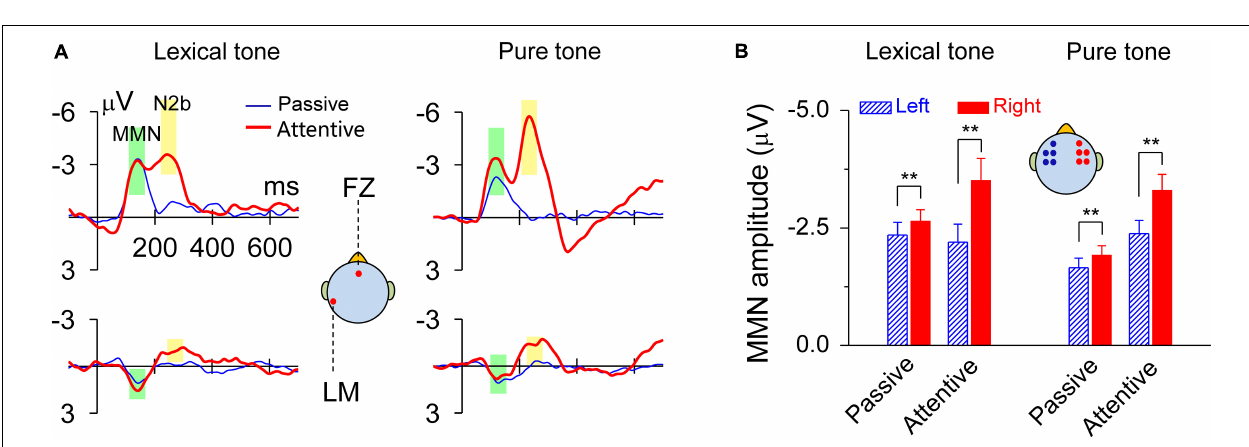
FIGURE 2 | MMN responses to lexical tone contrasts or to pure tone contrasts were lateralized to the right scalp. (A) Grand average traces of MMN in response to lexical tone and pure tone contrasts at FZ and LM (left mastoid) electrodes. The data are band-pass filtered (1–25 Hz) for graphic illustration only. (B) Statistics of average MMN responses from five electrodes (AF3, F3, FC3, F5, and FC5) on the left scalp and five (AF4, F4, FC4, F6, and FC6) on the right scalp. Asterisks indicate a statistically significant difference. ∗ P < 0.05; ∗∗ P < 0.01. Vertical lines represent one standard